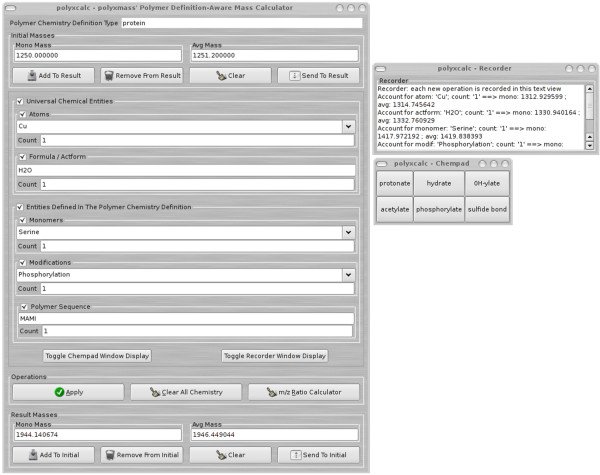
The polyxcalc programmable mass calculator. The mass calculator is polymer chemistry definition-aware, and in this figure it is represented pre-loaded with the "protein" polymer chemistry definition (top of the left window). When, upon opening of the calculator, a polymer chemistry definition is loaded, its chemical entities (monomers and chemical modifications, as shown) become available in the calculator's widgets; otherwise only atoms and formulas can be used. The calculator is programmable, and a simple syntax allows the definition of the layout of a "chemical pad" to perform quick chemical calculation tasks in the calculator.